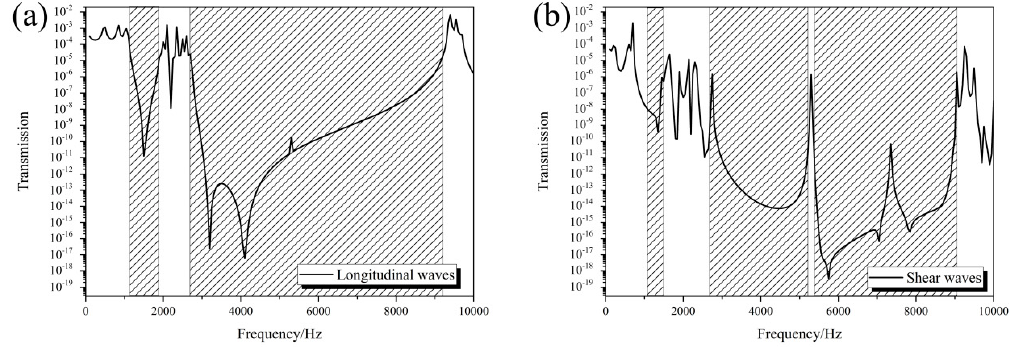
Figure 6. Transmission curve of the 3D star structure for longitudinal waves ( a ), and for shear waves ( b ).